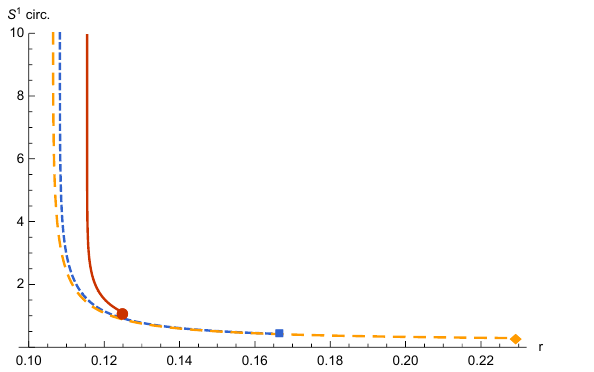
Figure 21 . The “circumference” of loops of constant r . ‘ is set to unity with A = 10 . Three values of m ( 6 − 1 , 8 − 1 , and 9 − 1 ) are shown (in solid red, dotted blue, and dashed orange respectively). The value at the horizon radius r = r h is marked by a